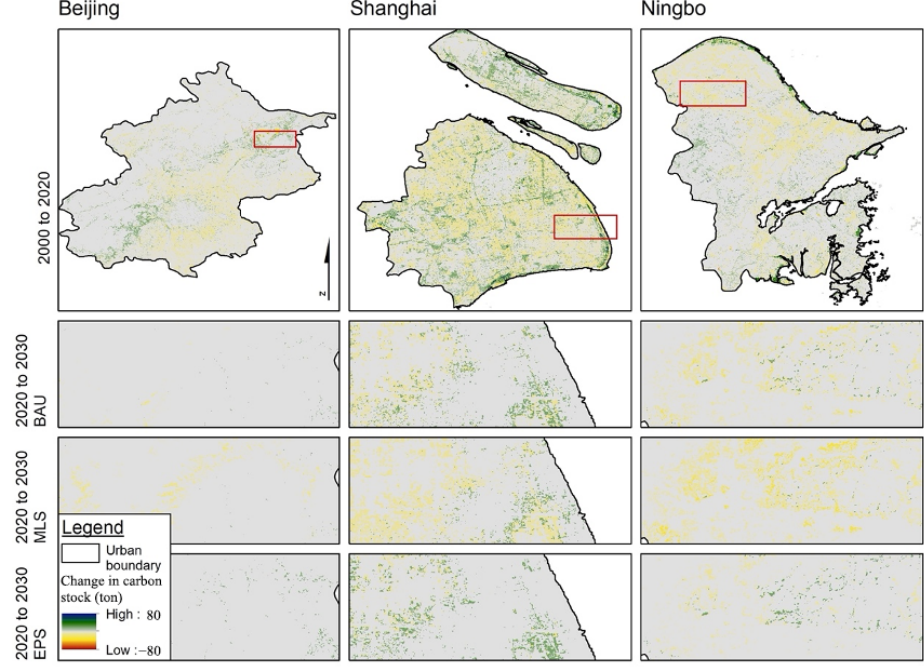
Figure 7. Carbon stock in Beijing, Shanghai, and Ningbo for 2000 to 2020 and 2020 to 2030 under three different scenarios (BAU, MLS, and EPS). Lower panels show detail within red boxes shown in upper panels.